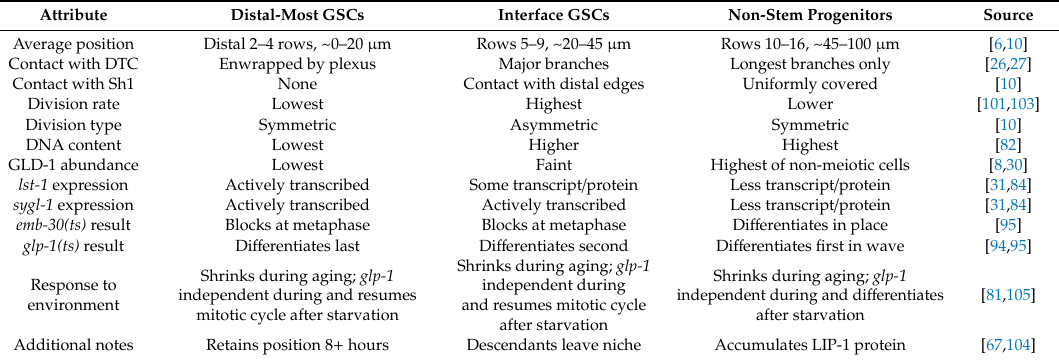
Table 1. Anatomical, genetic, and cell-cycle features of non-meiotic PZ